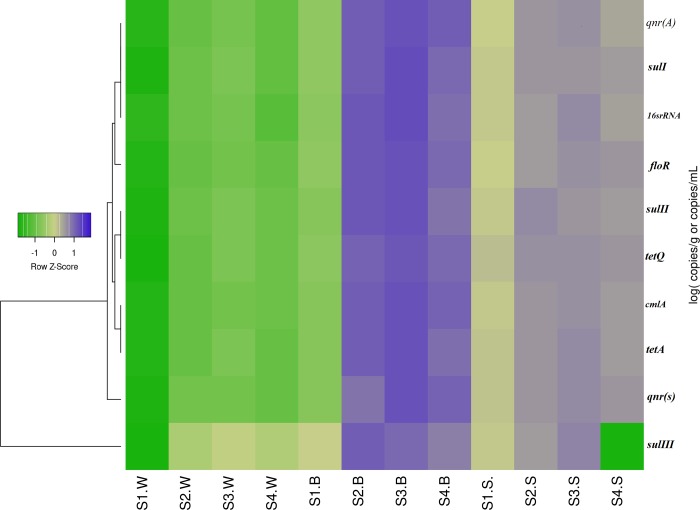
Heatmap of the abundances of the ARGs in biofilm (S1-4.B), sediment (S1-4.S and water (S1-4.W) of the Weihe-river.Blue indicates higher abundance of ARGs detected, while green indicates lower abundance of ARGs detected.